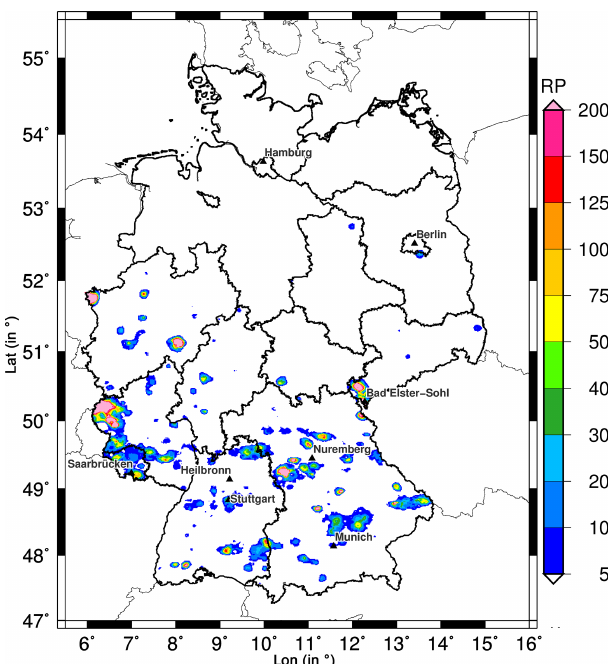
Figure 13. Return period (RP) of the highest 24h rainfall totals that occurred during the study period at each grid point (REGNIE precipitation data; reference period: 1951–2017, summer